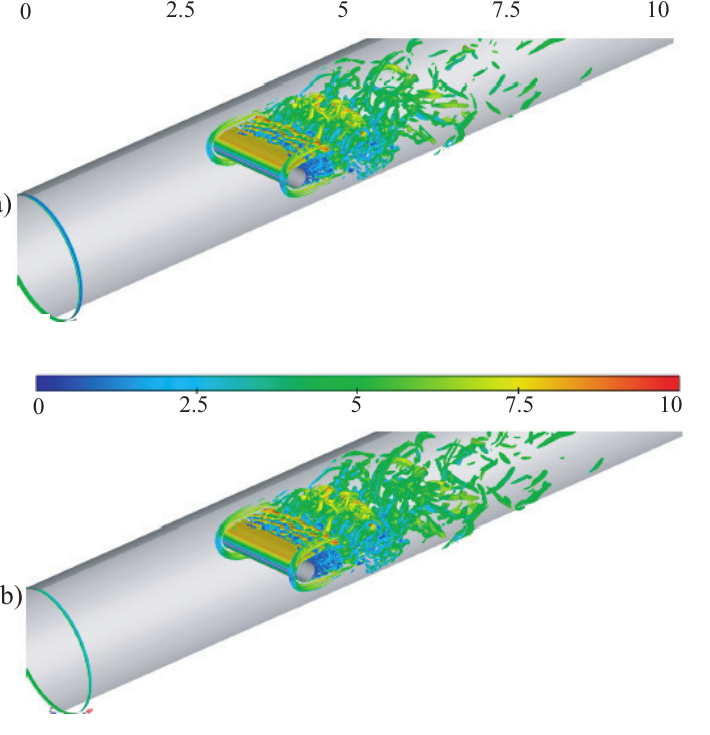
Figure 10. Contours of Q -criterion ( a ) and λ 2 -criterion ( b ) for Re c = 39,809. The presented fields of physical quantities illustrate the general picture of the separated flow near the cylinder. As quantitative estimates of the accuracy of solving this problem, the most interesting are the spectra of pressure fluctuations on the cylinder surface and acoustic loads on the pipe walls. At each point on the wall, as well as at some selected points, the Fourier transform of the data is performed, expressing the dependence of pressure on time. The time dependence of overpressure on the pipe wall is shown in Figure 11 at x = 0.1 m. Dotted lines show pressure levels corresponding to ± 200